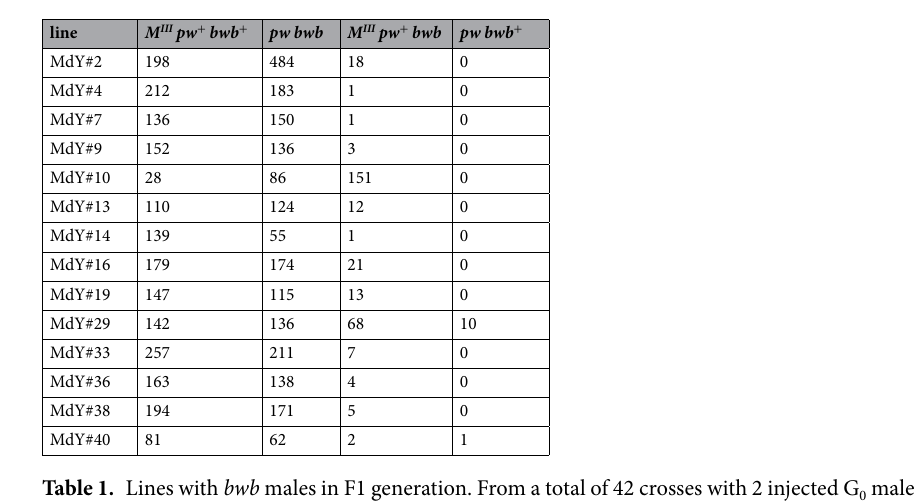
Table 1. Lines with bwb males in F1 generation. From a total of 42 crosses with 2 injected G 0 males each, 14 lines with bwb mutant F1 males were recovered. MdY#29 and MdY#40 also produced bwb + wildtype females. The numbers of F1 flies with different phenotypes are shown for each line. Presence of M III indicates a male